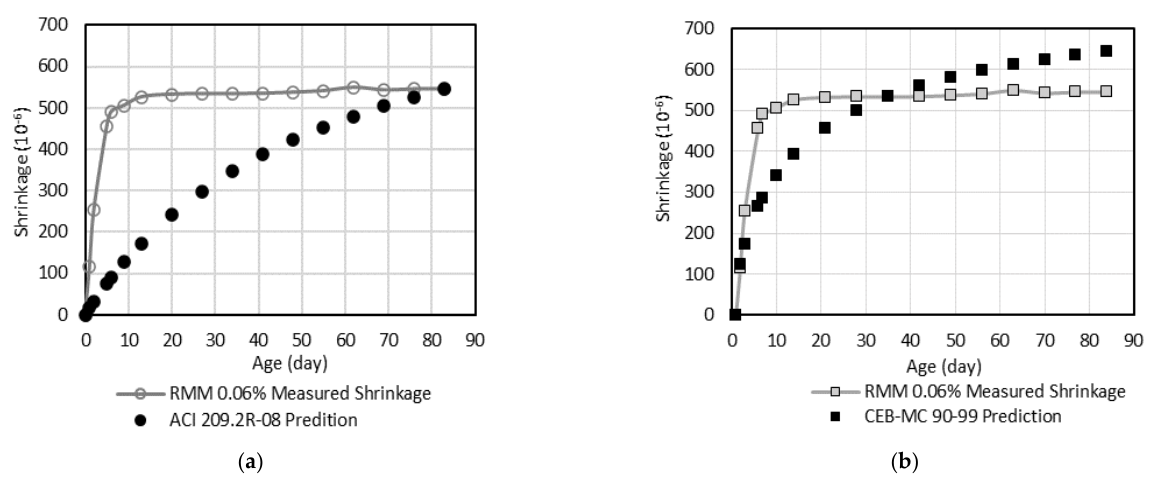
Figure 6. Comparison between the measured shrinkage and the predicted shrinkage by ACI 209.2R-08 ( a ) and CEB-MC 90-99 ( b ) models.